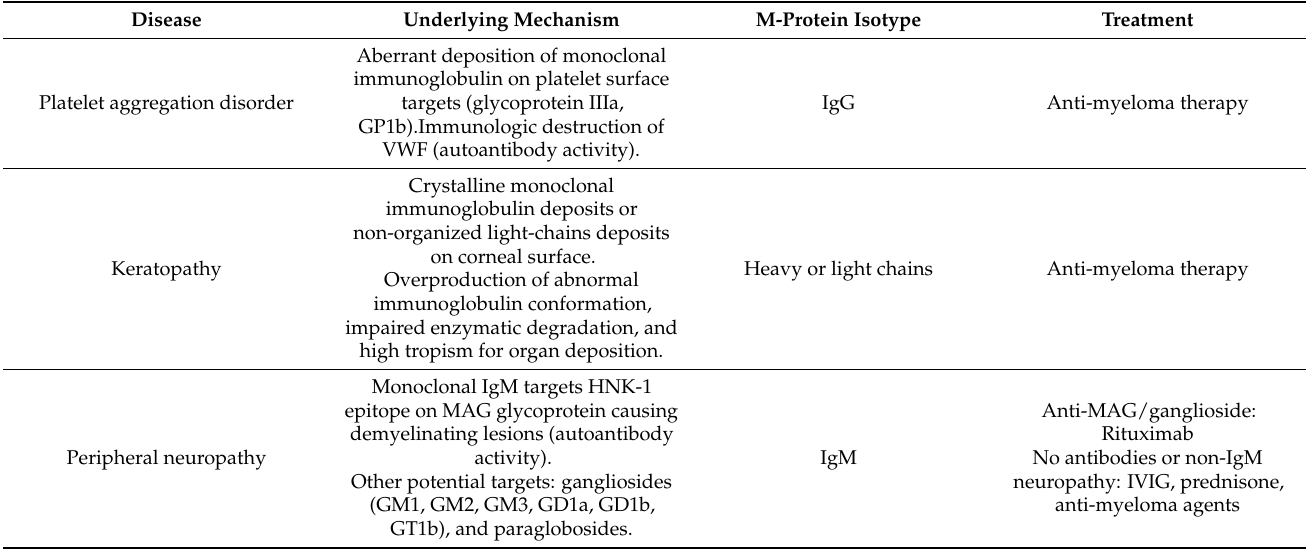
Table 3. Summary of treatment recommendations for other infrequent MGCS. IVIG, intravenous immunoglobulins; anti- MAG, anti-myelin associated glycoprotein; anti-myeloma agents: proteasome inhibitors, immunomodulatory drugs, +/ − high-dose melphalan with autologous stem cell transplant; VWF, von Willebrand factor; HNK-1, human natural